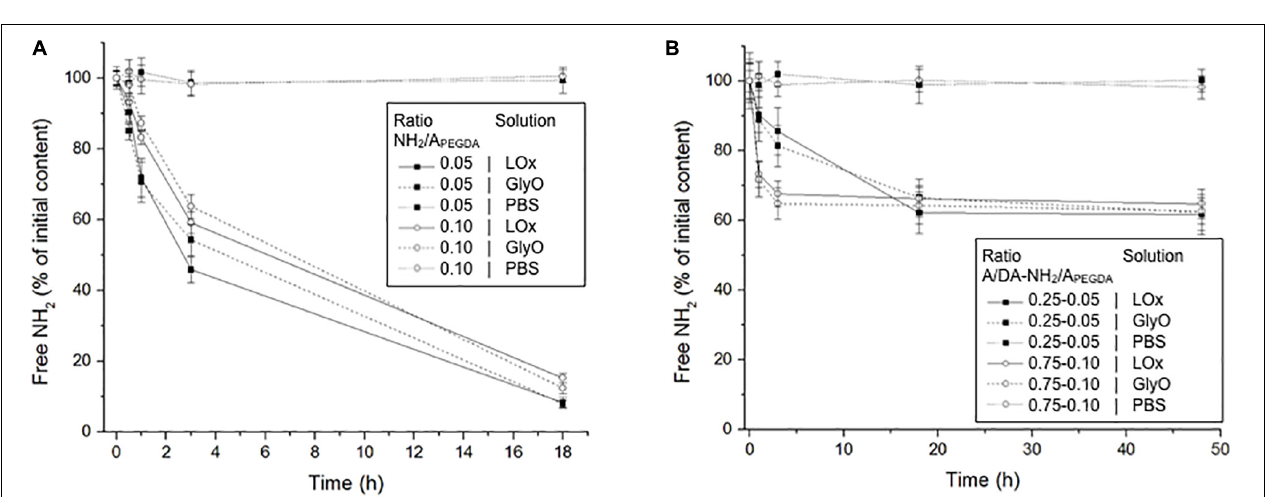
FIGURE 3 | (A) Equilibrium volume swelling ratios ( Q eq ). Different letters indicate significant differences between samples (one-way ANOVA, p < 0.05). (B) Hydrogel mesh size estimations ( ξ ) obtained either with equilibrium swelling and rubber elasticity theories. Different letters indicate significant differences between samples (one-way ANOVA, p < 0.05). Letters with no sign are referred to ANOVA results of ξ calculated using equilibrium swelling data, whereas those with an apostrophe indicate ANOVA results obtained for ξ estimated from mechanical data.